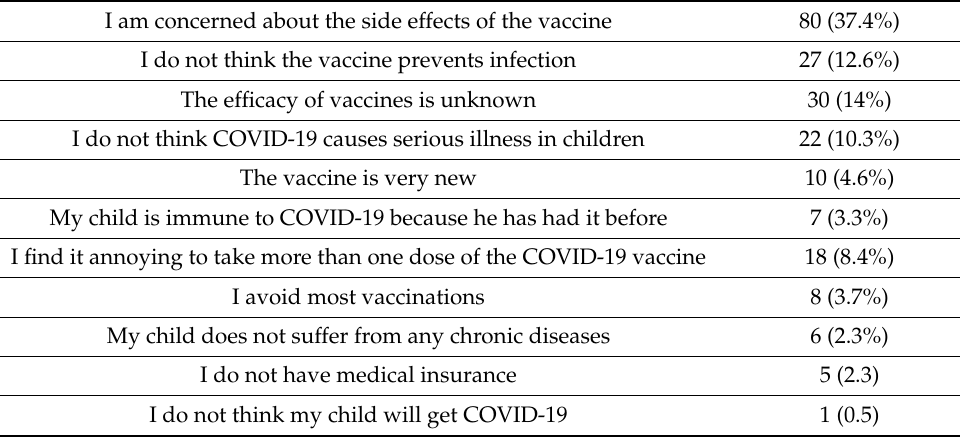
Table 6. Reasons behind the parental refusal to vaccinate their children n =